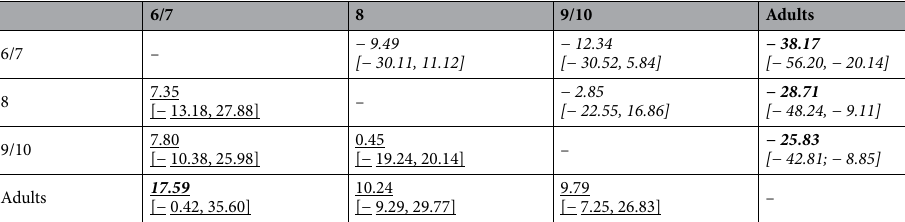
(cid:31) RT (cid:31) RT distractor − standard ). The upper